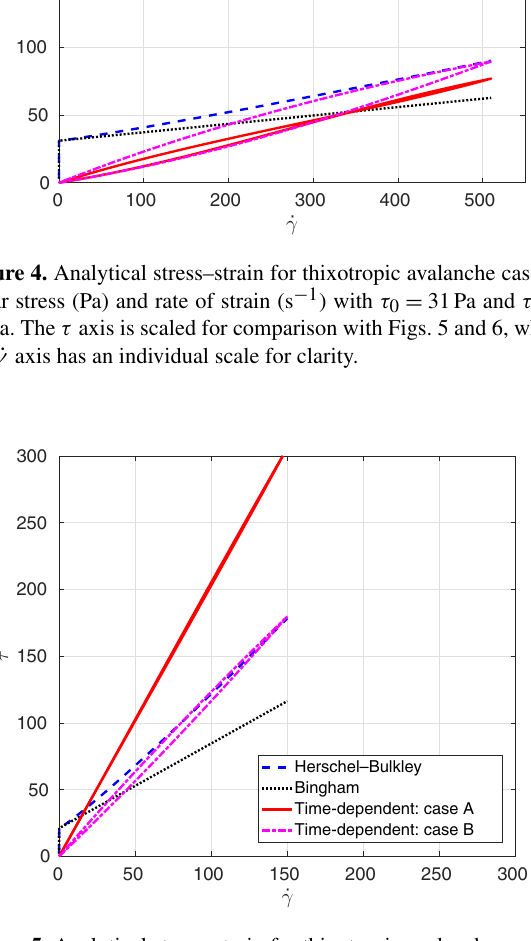
Figure 5. Analytical stress–strain for thixotropic avalanche case 2: shear stress (Pa) and rate of strain (s − 1 ) with τ 0 = 21 . 1Pa and τ c = 165Pa. The τ axis is scaled for comparison with Figs. 4 and 6, while the ˙ γ axis has an individual scale for